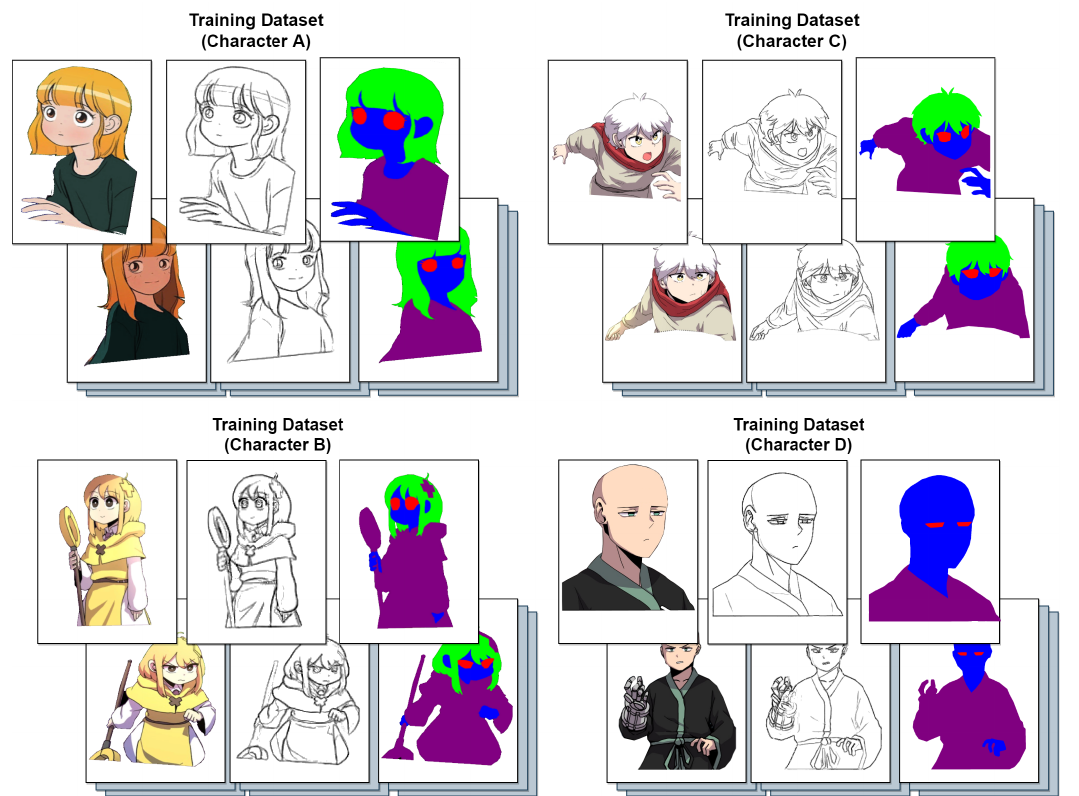
Figure 4. From left to right, (1) original image, (2) extracted line art be SketchKeras, (3) masked image for eyes, hair, skin, and clothes.